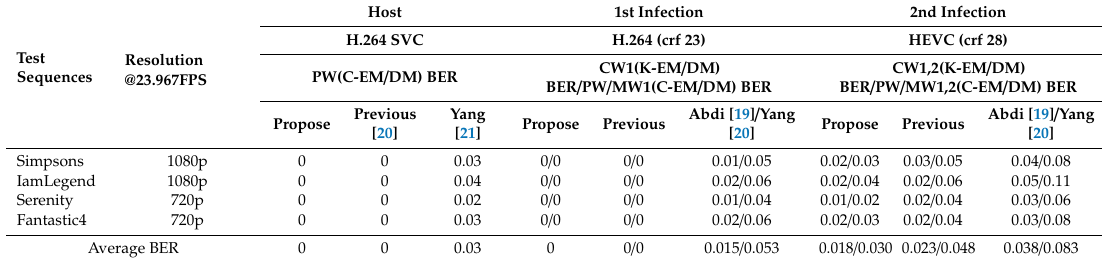
Table 4. BER results of pathogen, contagion, and mutant watermarks by H.264 / MPEG4 AVC and HEVC for high resolutions.